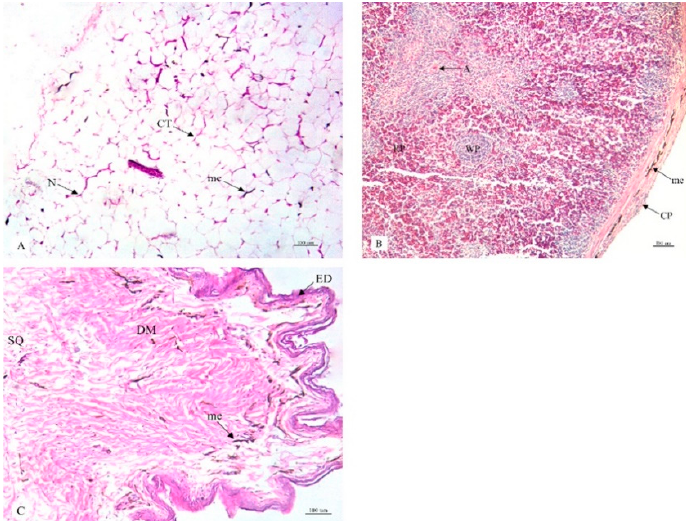
Figure 6. Histological location of melanin pigment in each organ; abdominal fat ( A ), spleen ( B ), skin ( C ). Abbreviations: CT, cytoplasm; N, nucleus; CP, capsule; RP, red pulp; WP, white pulp; A, central artery; ED, epidermis; DM, dermis; SQ, subcutis; me, melanin pigment. Low magnification, H&E stain.